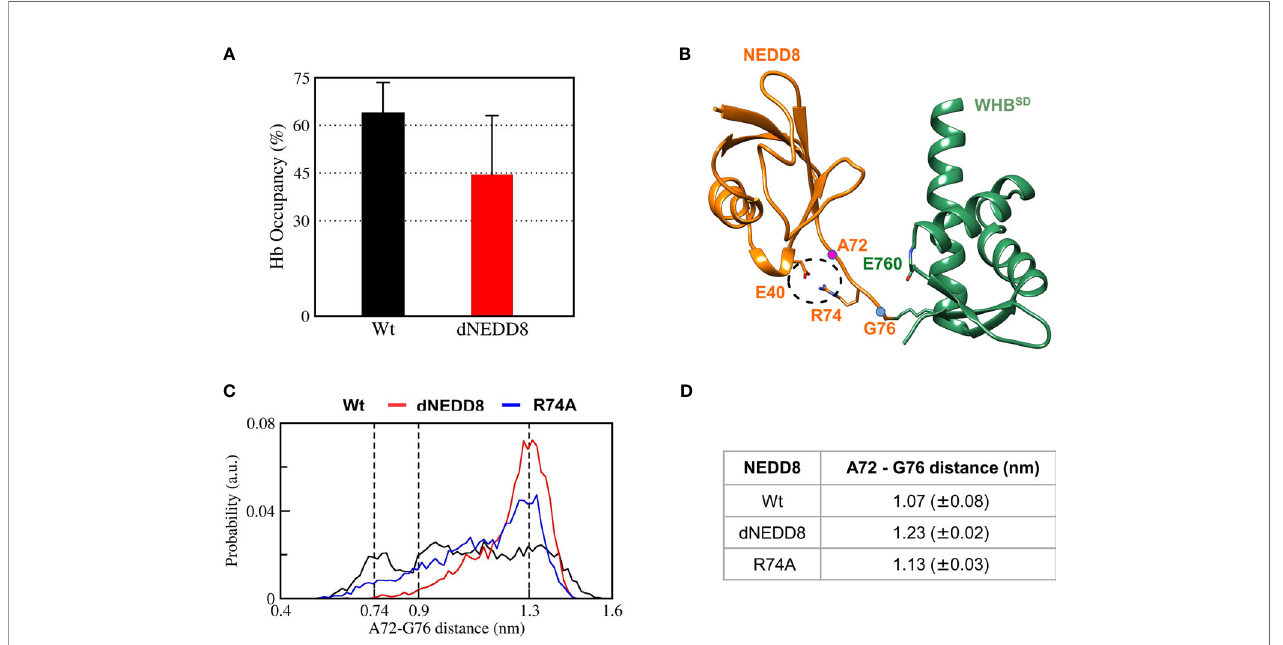
FIGURE 7 | R74-E40 salt-bridge may hinder NEDD8/WHB SD association by disallowing compact conformations of the NEDD8 C-terminal tail. (A) Mean± one standard error of R74/E760 hydrogen bond occupancy for NEDD8-wt and dNEDD8 conjugates. (B) Snapshot from trajectory 1 of Cul1-WHB SD ~NEDD8 showing an intramolecular salt-bridge involving R74/E40. The C a atom positions of A72/G76 are shown as pink spheres. (C) Combined probability distribution of the C-terminal tail conformation obtained from fi ve 300 ns trajectories for each conjugate. The A72-G76 distance varies from 0.74 to 0.9 nm in crystal complexes of Cul1/5- WHB SD ~NEDD8. (D) Mean ± one standard error of the C-terminal tail conformation across all fi ve trajectories for each